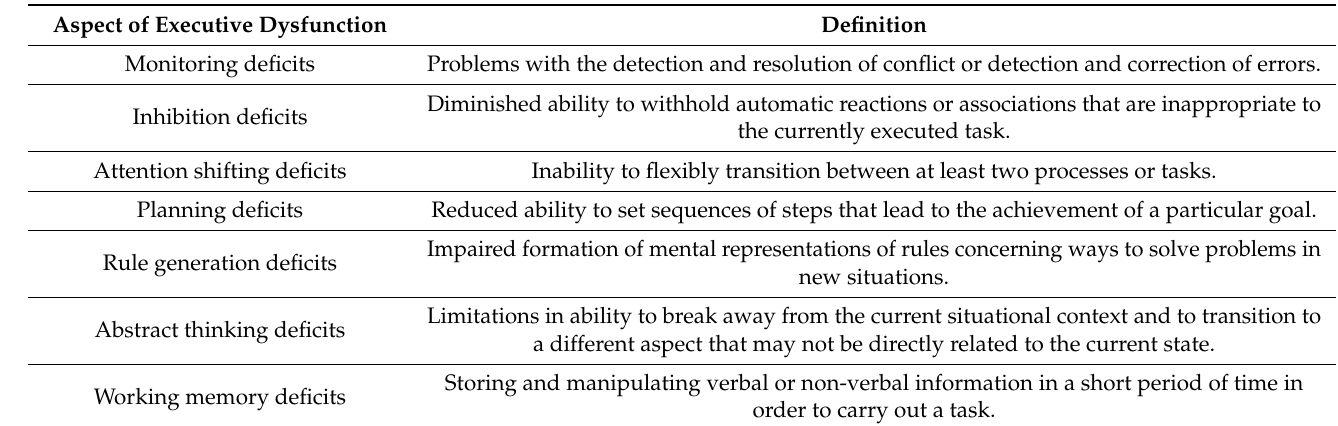
Table 2. Components of executive dysfunction in schizophrenia [130,131]. Aspect of Executive Dysfunction Definition Monitoring deficits Inhibition